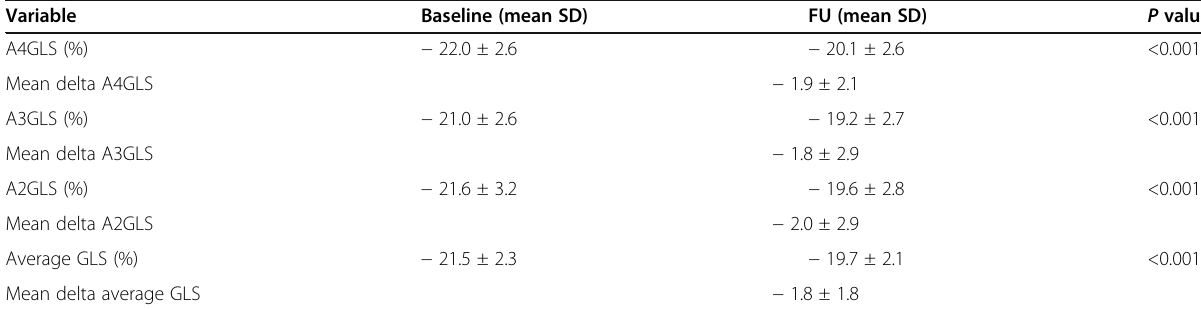
Table 4 Comparison of the baseline and FU levels of GLS Variable